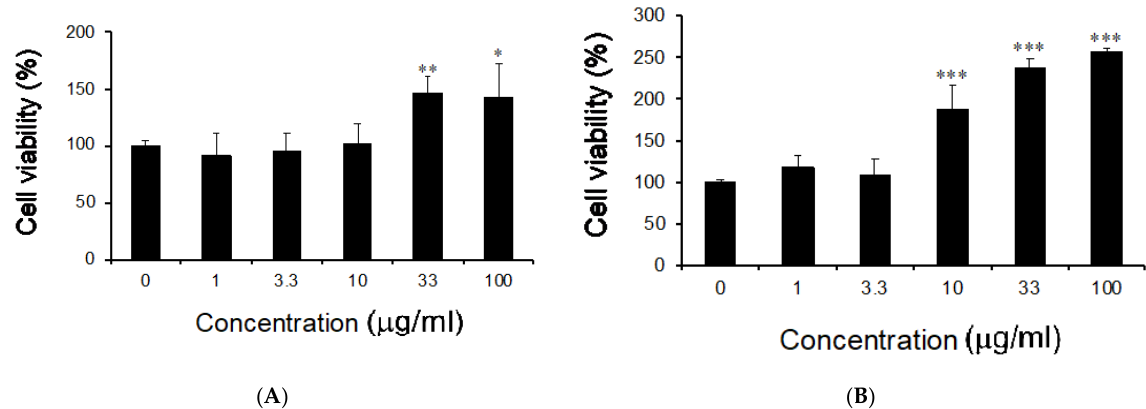
Figure 3. Effects of Morinda citrifolia seeds extract or oil on the cell viability in LPS-stimulated RAW264 cells. Cells were treated with M. citrifolia ( A ) seed extract or ( B ) oil for 0.5 h before incubation with LPS (200 ng/mL). The indicated concentration shows the final concentration of the test samples incubated with LPS for 24 h. Cell viability was measured using the Cell Counting Kit-8 assay. Data are presented as mean ± SD ( n = 4). * p < 0.05, ** p < 0.01, *** p < 0.001 compared to the sample with 0 (zero) concentration.